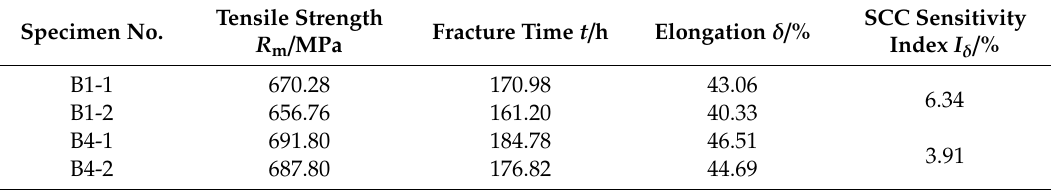
Figure 15. The SSRT curves for di ff erent solutions and dimensions. Table 3. The SSRT results of for di ff erent solutions and